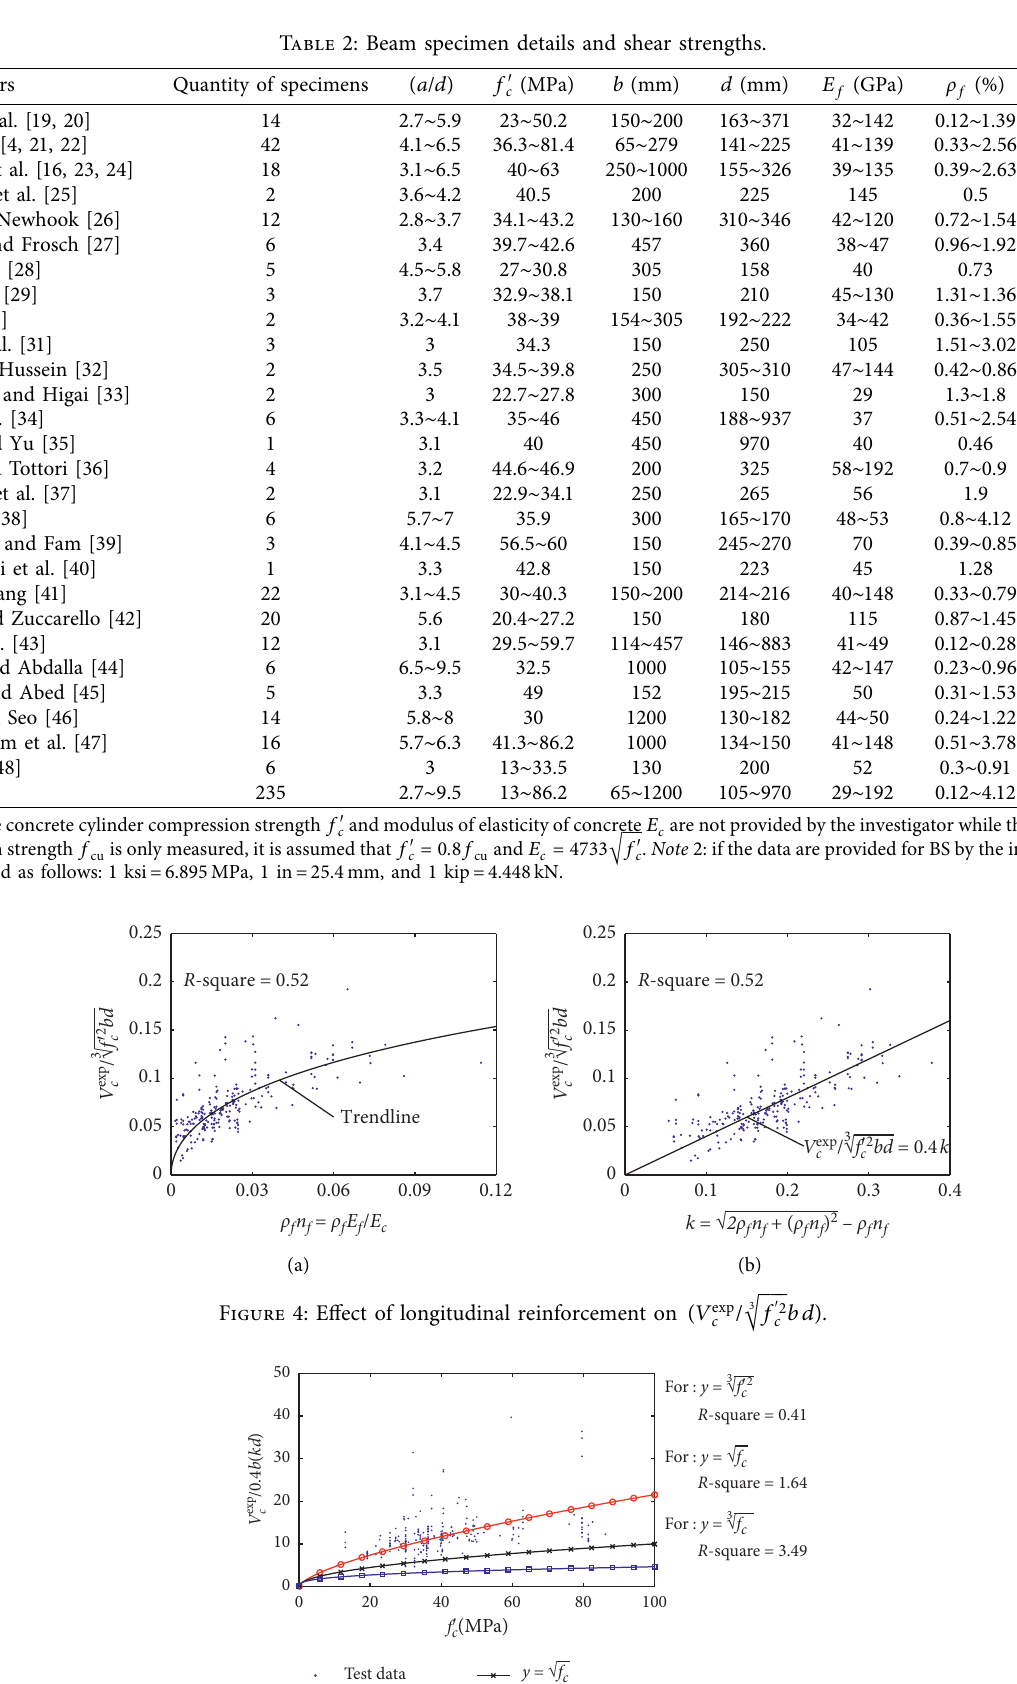
Figure 5: Effect of concrete compression strength on ( V exp